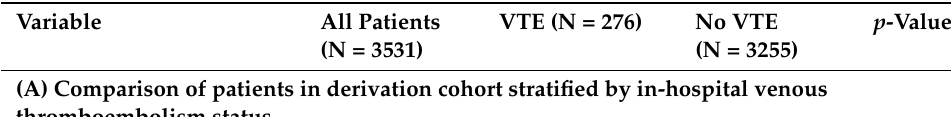
Table 1. Baseline characteristics of all COVID-19